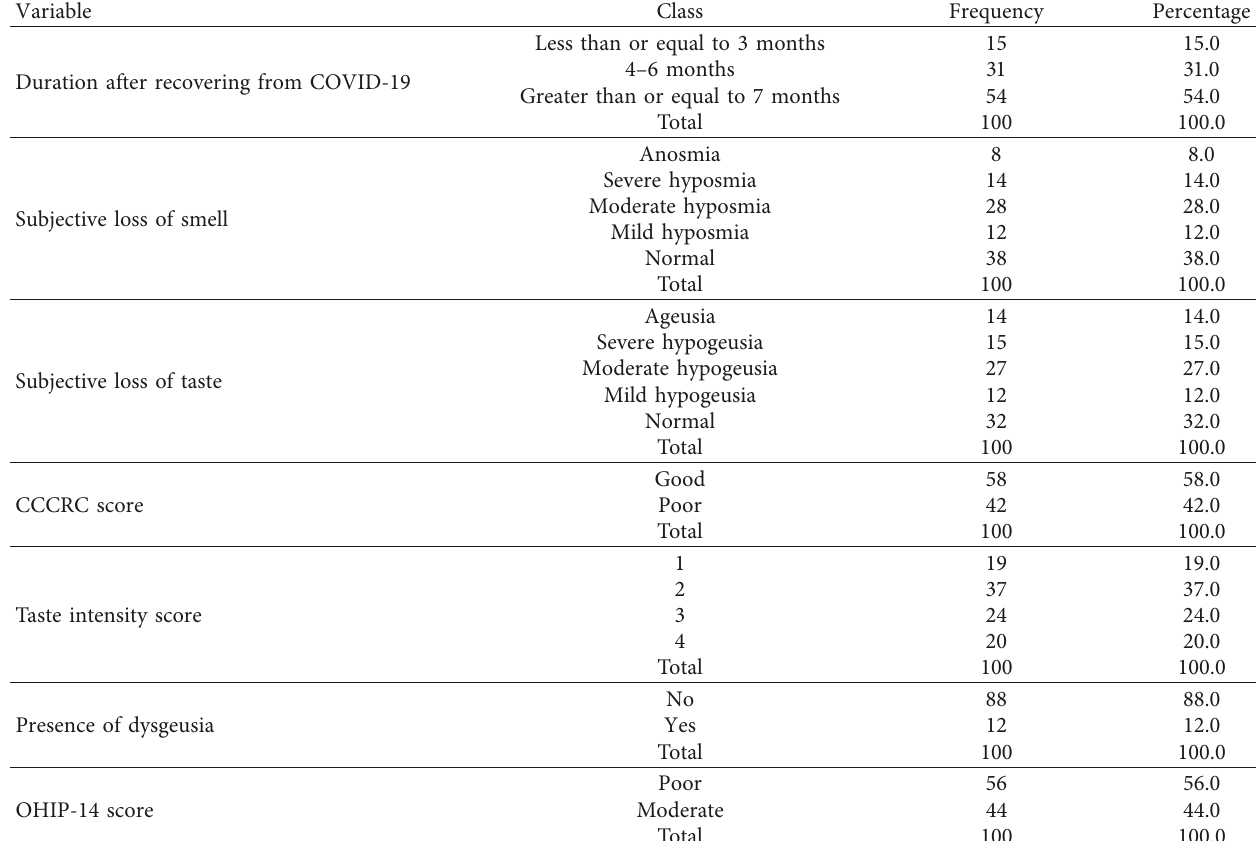
Table 2: Frequency and percentage distribution of patients based on duration after COVID-19, subjective loss of smell and taste, CCCRC score, taste intensity score, dysgeusia, OHIP-14